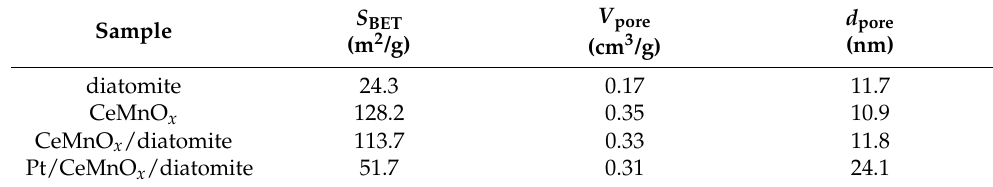
Figure 2. SEM images of ( a , b ) diatomite, ( c , d ) CeMnO x , ( e ) CeMnO x /diatomite, and ( f – i ) elemental mappings of CeMnO x /diatomite. Table 1. BET surface areas ( S BET ), pore volumes ( V pore ), and pore diameters ( d pore ) of the